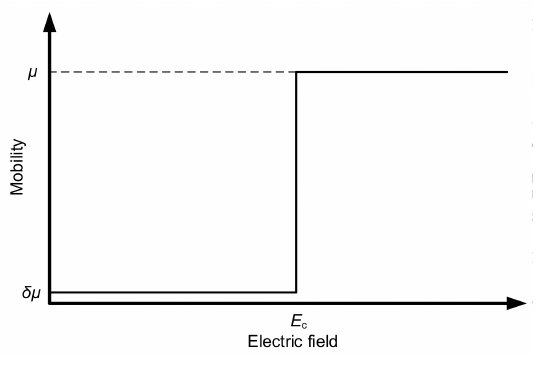
Figure 9. Field-dependent mobility used in the